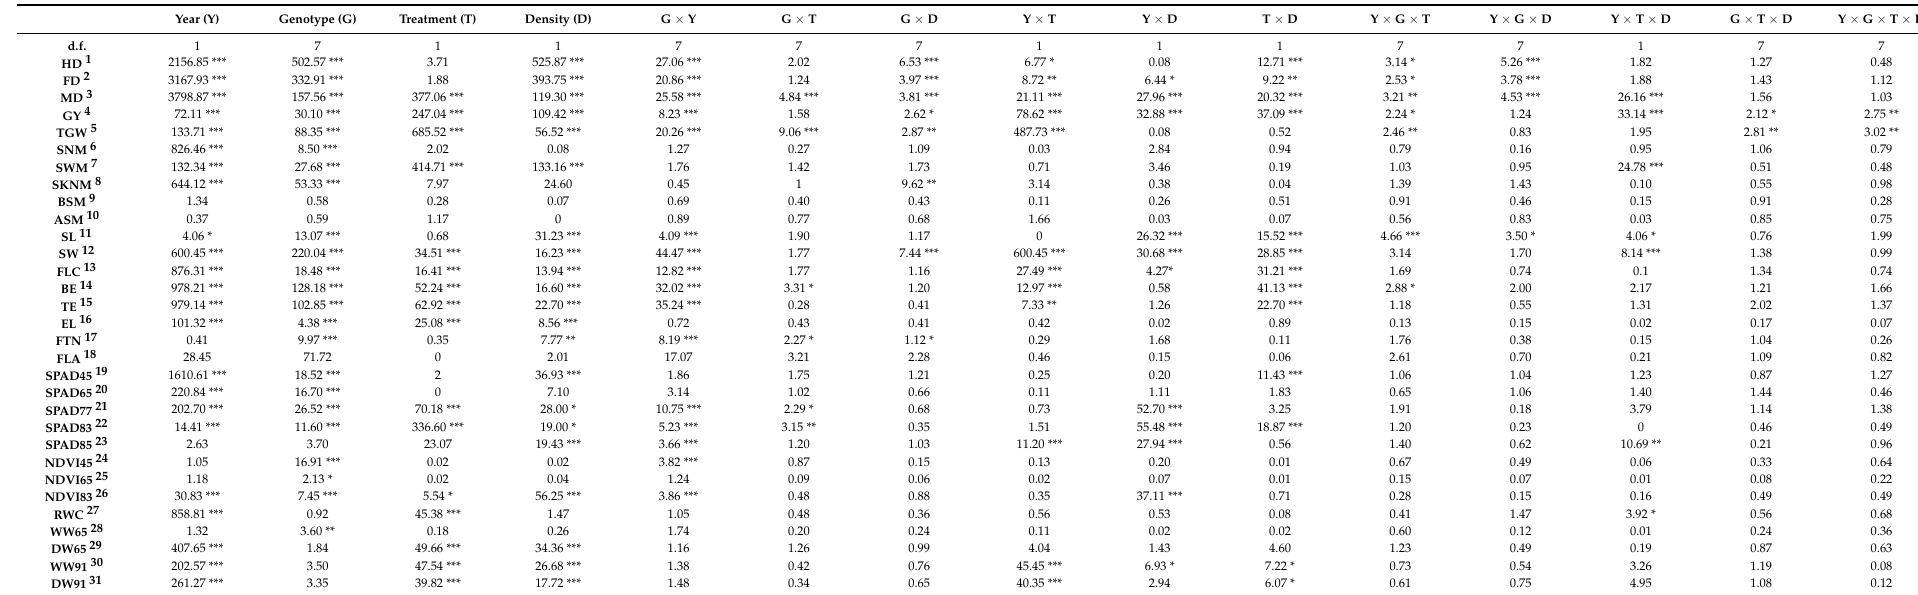
Table 1. Significance of year, genotype, treatment and sowing density effects and interactions on plant development, morphological and physiological parameters and on yield components, based on the Chi-squared test for eight near-isogenic lines of durum wheat. In the REML analysis, F = Wald statistic/d.f., combined over the two years. *, **, *** significant at the p < 0.05, 0.01 and 0.001 probability levels,